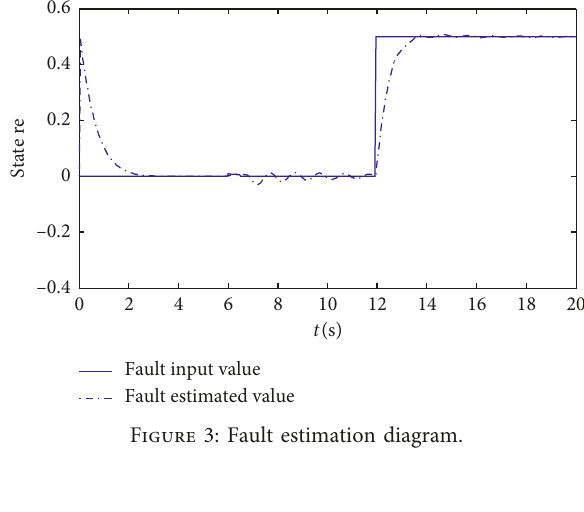
Figure 3: Fault estimation diagram.